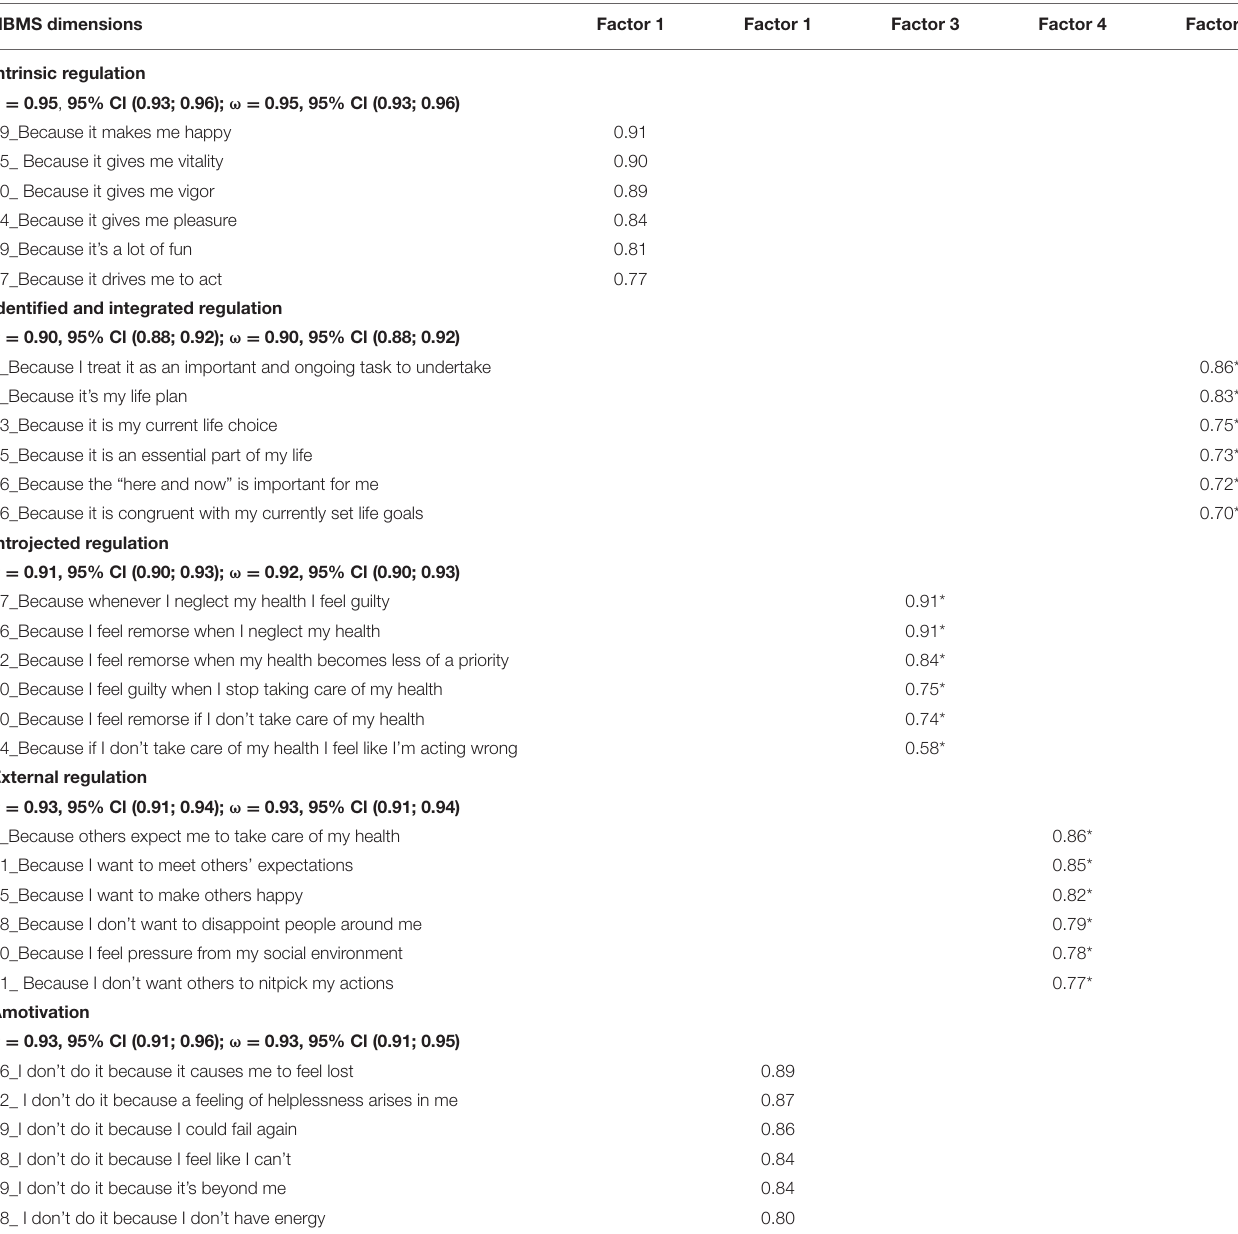
TABLE 3 | Factor loadings in EFA for 30-item Health Behavior Motivation Scale (HBMS), Study 1. HBMS